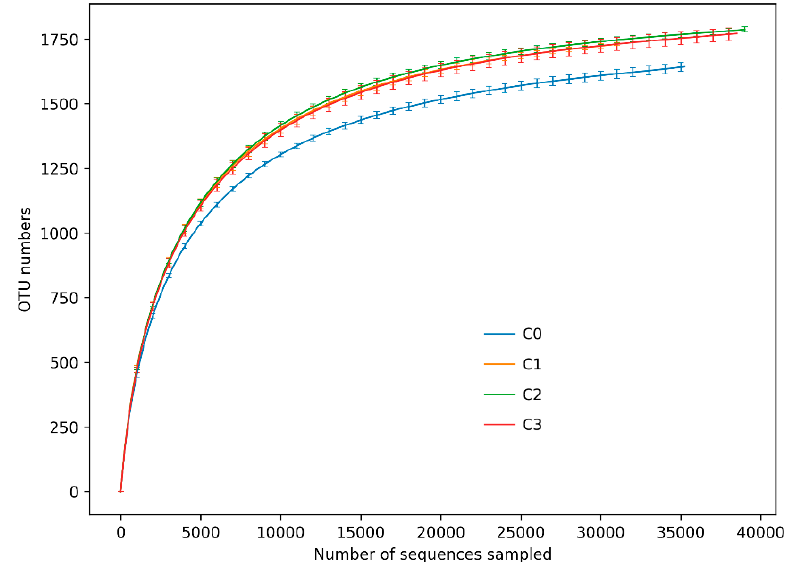
Figure 1. Rarefaction curve of 16S rRNA genes of 97% similarity from soils amended with different biochar rate. Bars above the scatter points represent the standard error of three replicates. Table 3. Illumina MiSeq sequencing of bacterial data and bacterial community diversity indices (at 97% sequence similarity) based on 16S rRNA gene.